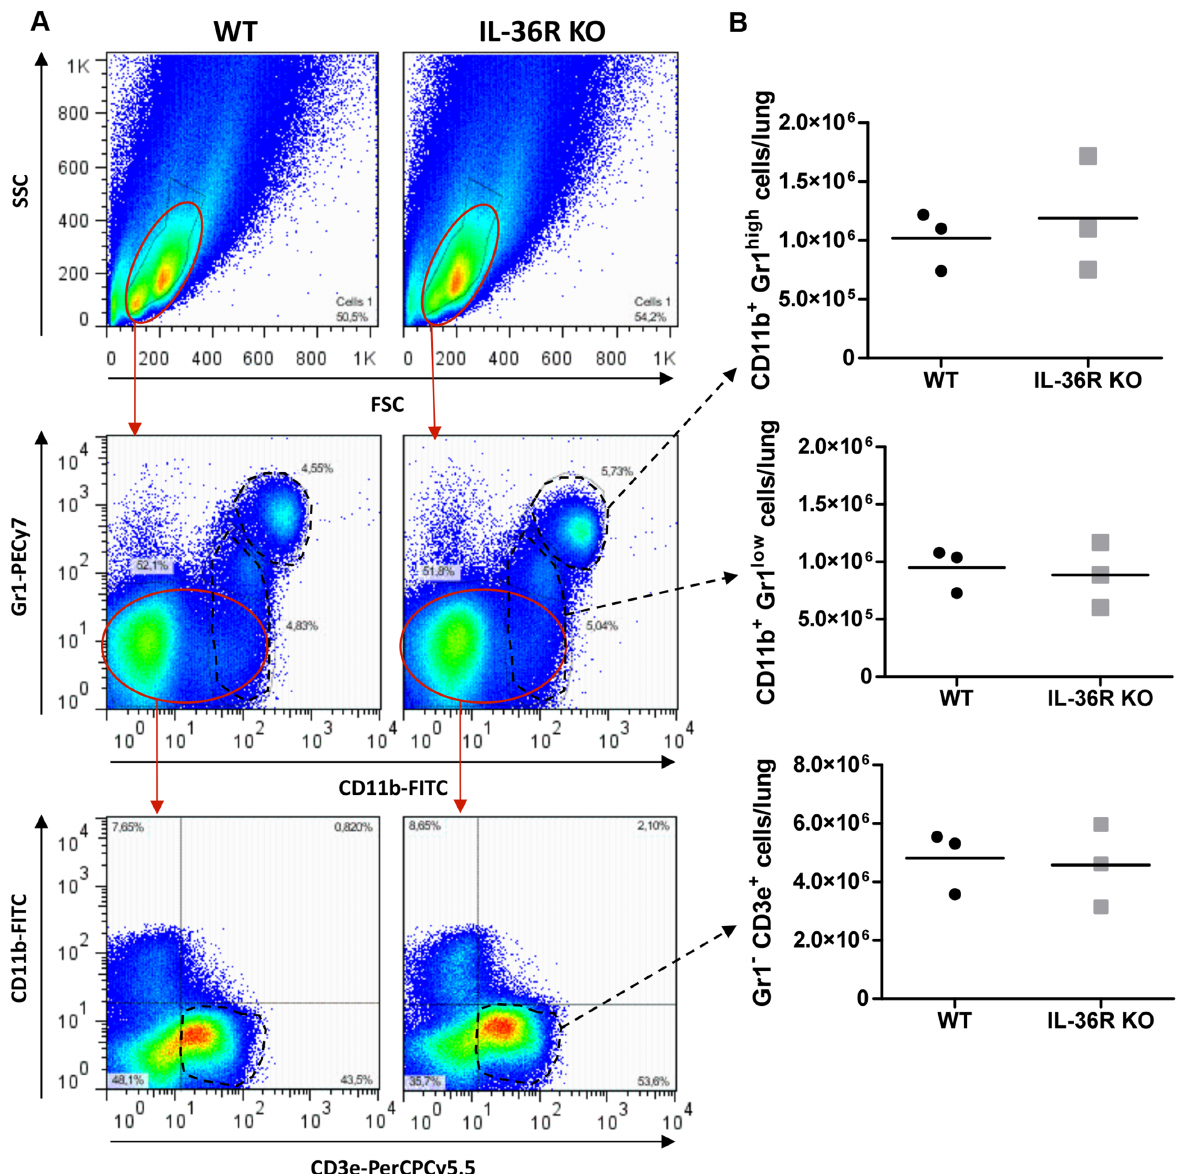
Fig 11. Unaffected lung inflammatory cell infiltration in the absence of IL-36R pathway after M . tuberculosis infection. Infiltrating cells in the lungs of IL-36R deficient (right panels) and wild-type mice (left panels) were isolated on day 28 after M . tuberculosis H37Rv infection, and analyzed by flow cytometry for the expression of CD11b, Gr1 (Ly6G/6C) and CD3. Gating strategy and representative dot blots are shown (A). Results expressed as the absolute number of CD11b + Gr1 high , CD11b + Gr1 low and Gr1 low CD3 ε + cells per lung are from 3 individual mice with mean values as horizontal bars